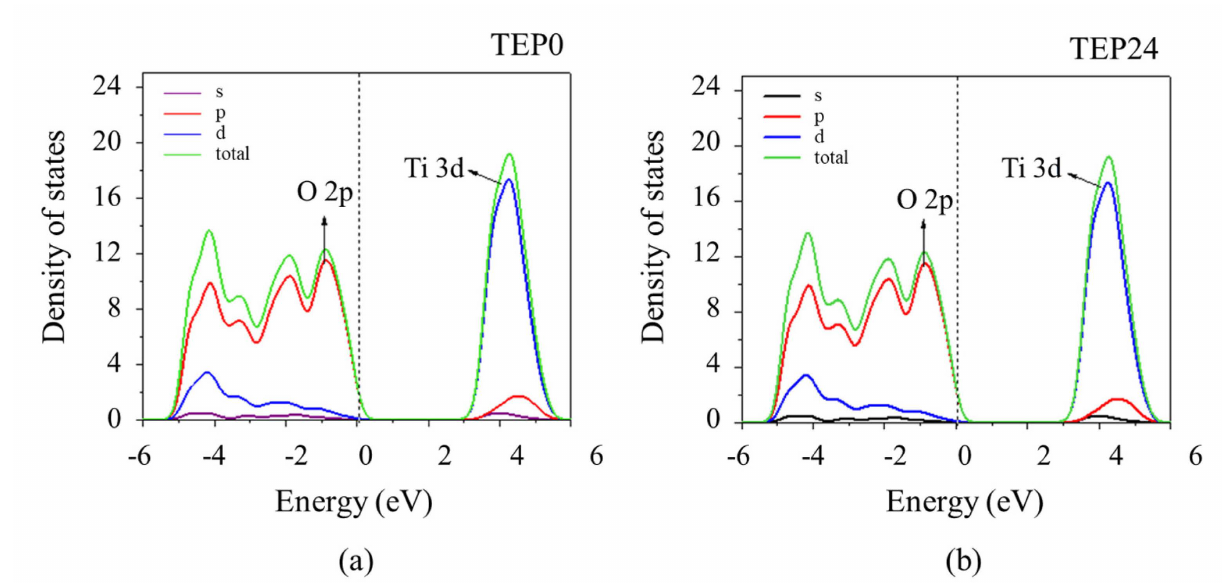
Figure 7. Density of states for ( a ) TEP0 and ( b ) TEP24. Green solid lines: TDOS, red solid lines: O 2p states, and blue solid lines: Ti 3d states. The black dashed line represents the position of the Fermi